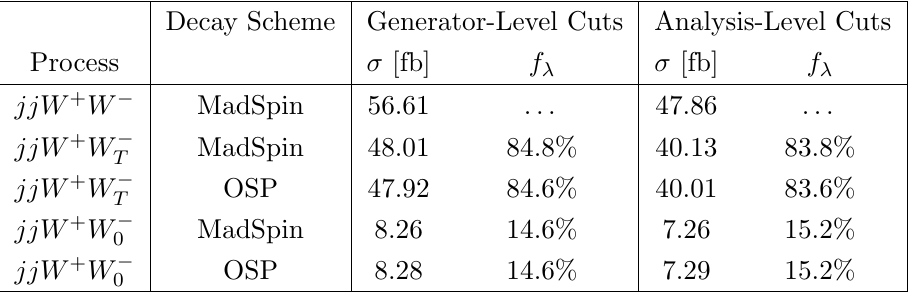
at O ( (cid:11) 2 (cid:11) 2 s EW (cid:21)